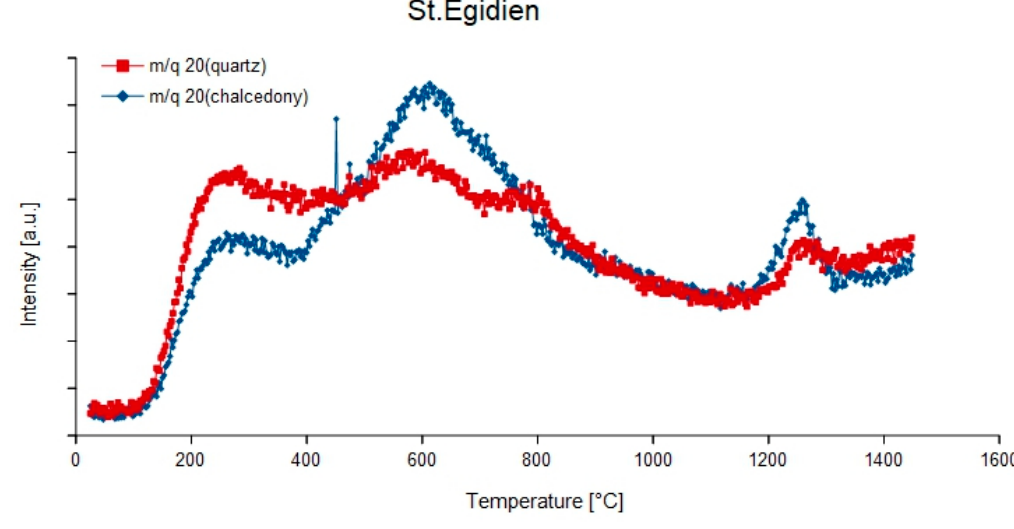
Figure 9. Degassing curves of the mass-charge ratio 20 ( 1 H 19 F) of quartz and chalcedony in the agate sample from St. Egidien, Germany.